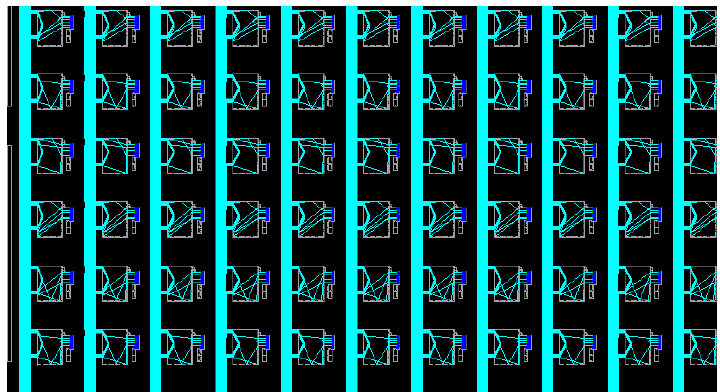
Figure 19. Test pattern of the hex line & PIPs along the vertical direction.